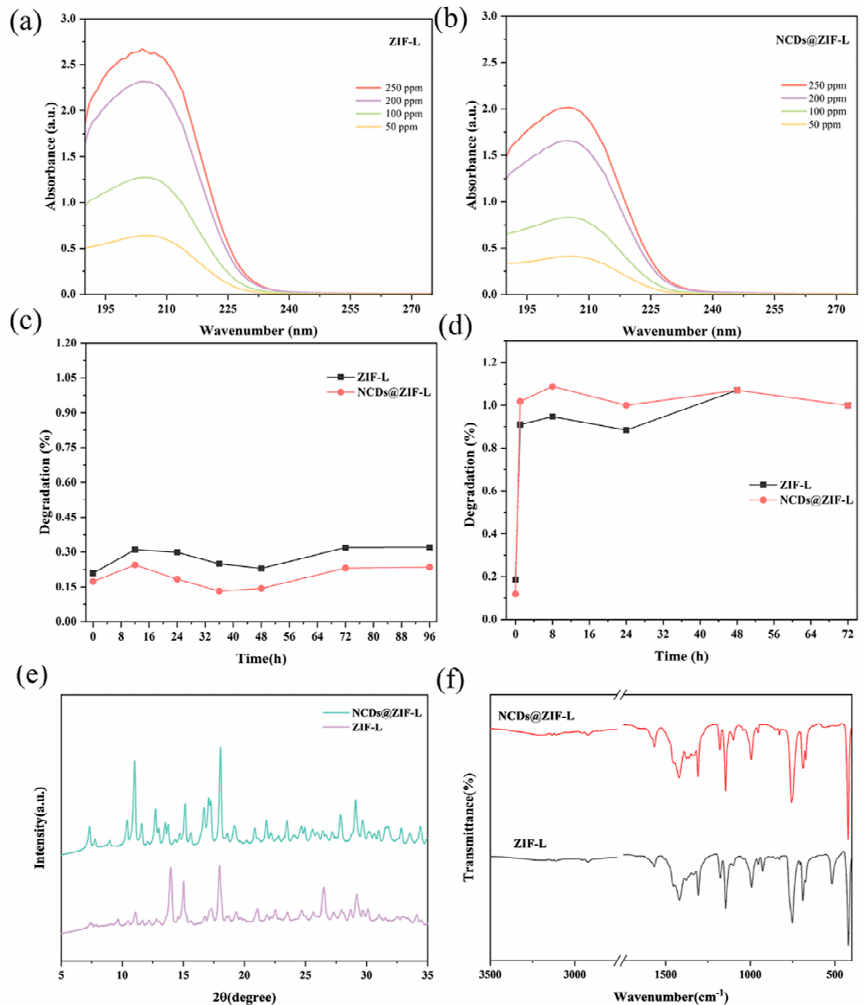
Figure 4. UV-Vis spectra of ZIF-L ( a ) and NCDs@ZIF-L composites ( b ) in DI water at different concentrations; degradation rate (%) of ZIF-L and NCDs@ZIF-L composites at different immersion times in DI water ( c ) and in acidic solutions ( d ); XRD ( e ) and FT-IR spectra ( f ) of ZIF-L and NCDs@ZIF-L composites after prolonged immersion.